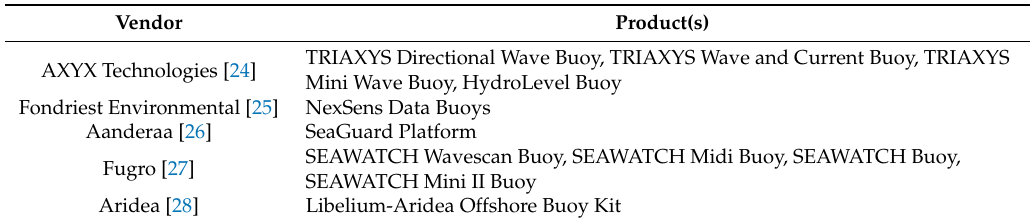
Table 2. Commercial-Based Water Quality Monitoring